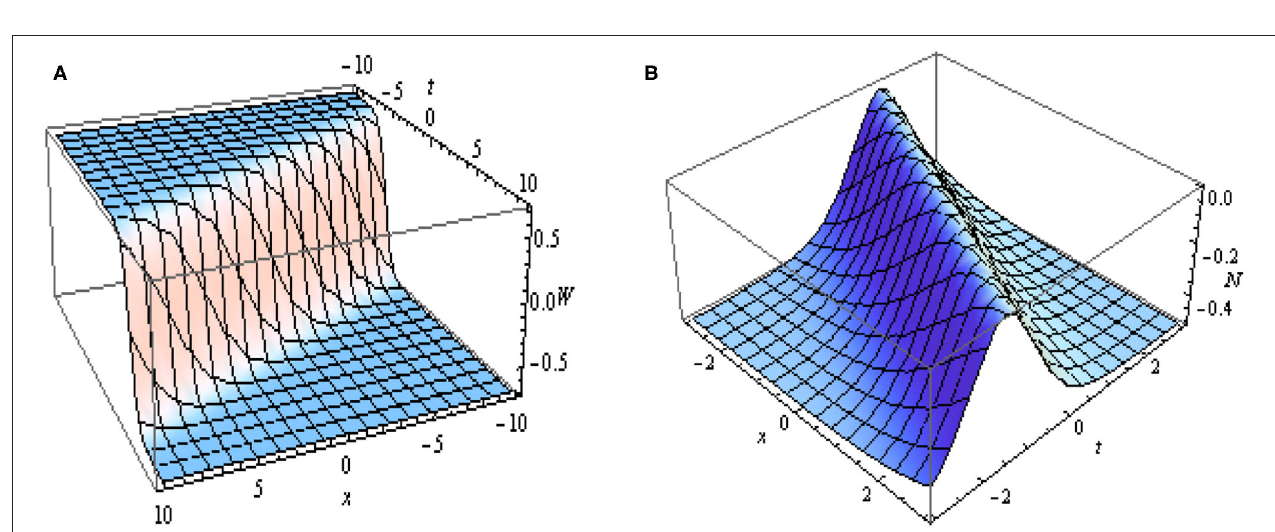
W ( x , t ) N ( x , t ) and given in Equations (38) and (39) with values of parameters as m | | | |